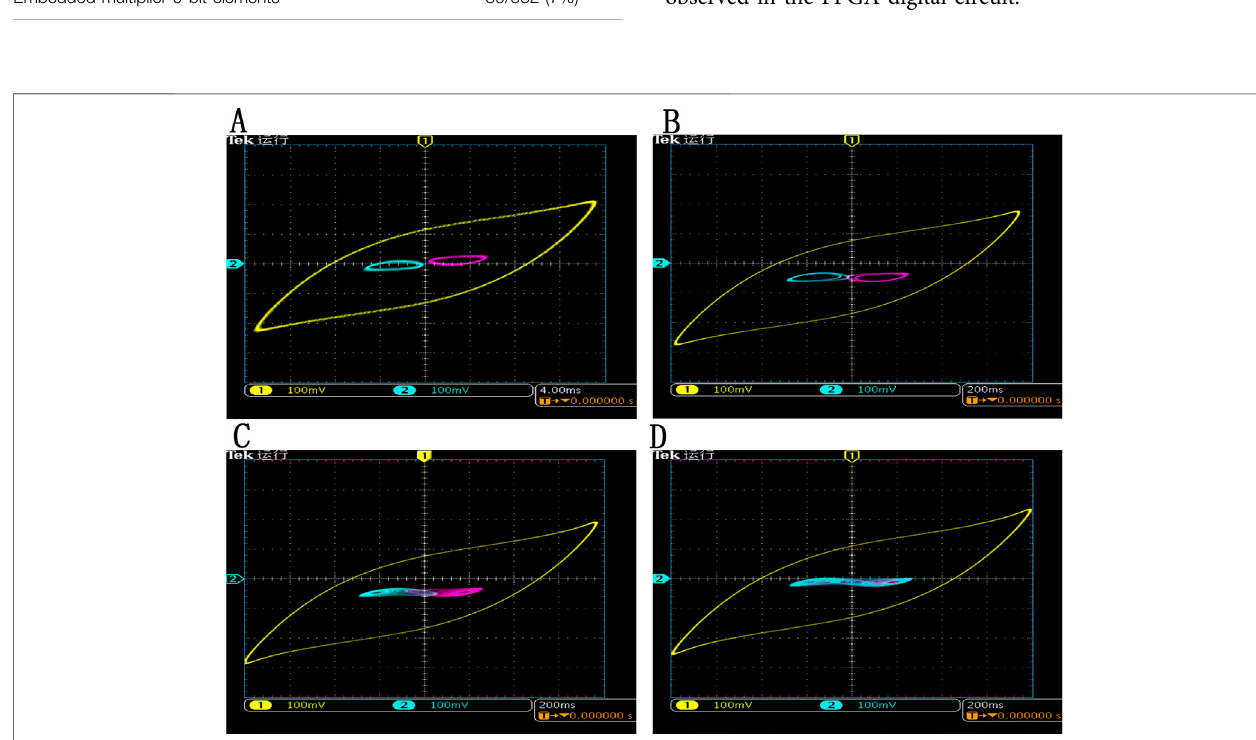
FIGURE7| CoexistinghiddenattractorsbasedontheFPGA. (A) α (cid:1) 60,[ x 0 , y 0 , z 0 ] (cid:1) [0.3200, − 0.1517,1.0667], (B) α (cid:1) 63,[ x 0 , y 0 , z 0 ] (cid:1) [0.3100, − 0.1440,0.9841], (C) α (cid:1) 69, [ x 0 , y 0 , z 0 ] (cid:1) [0.2900, − 0.1305, 0.8406], (D) α (cid:1) 72, [ x 0 , y 0 , z 0 ] (cid:1) [0.2900, − 0.1288, 0.8056].